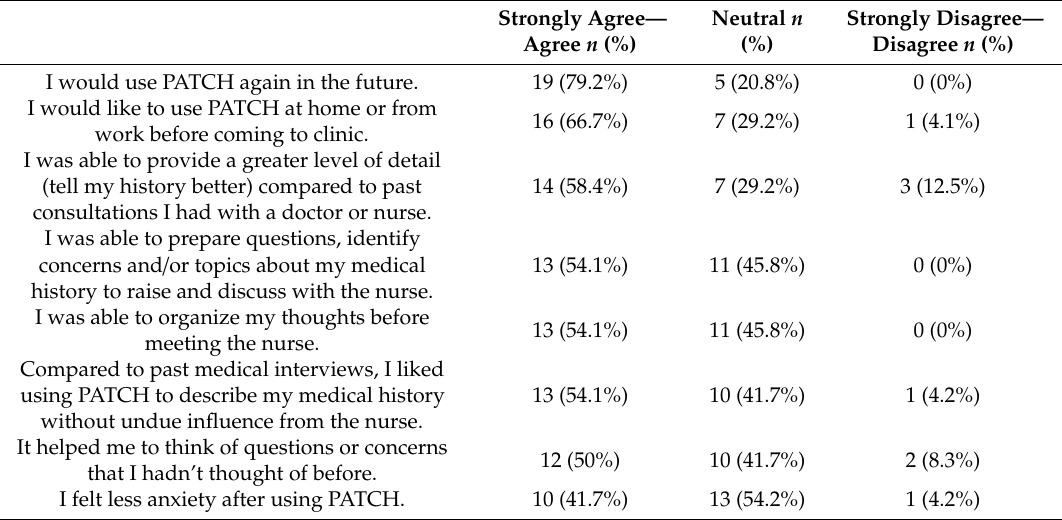
Table 2. Patients’ perceptions of PATCH assessment ( n =